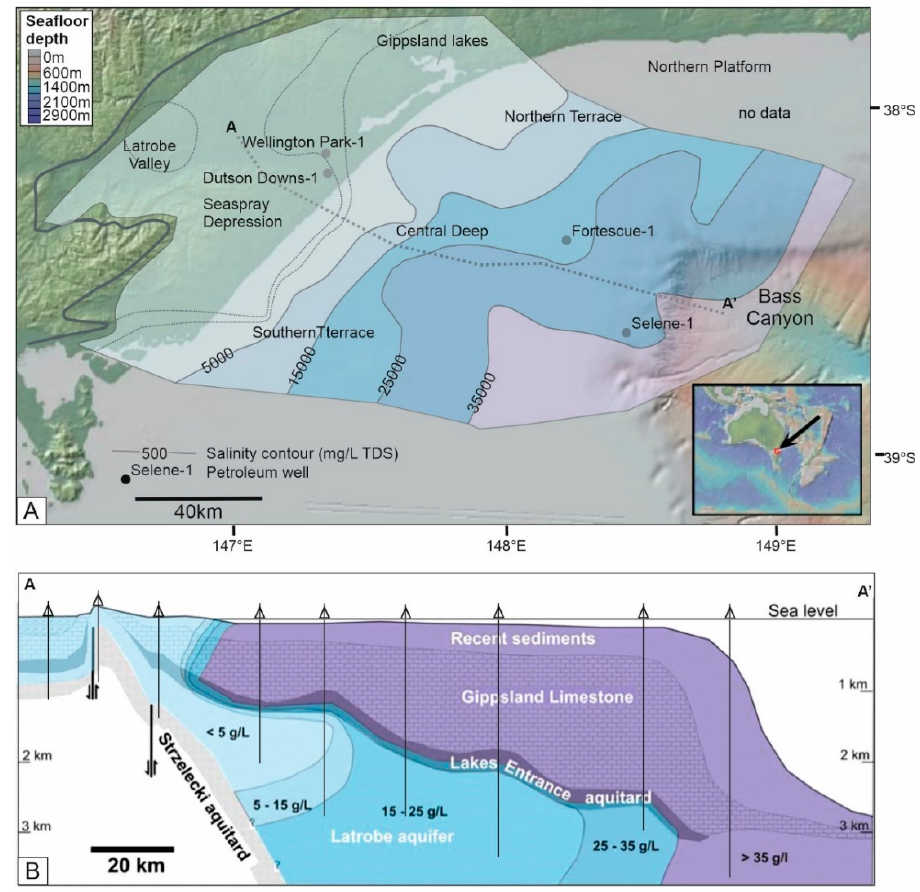
Figure 16. ( A ) Location map and salinity distribution in the Latrobe aquifer (mg/L) in the post-1980 period. Salinity is representative of the upper part of the Latrobe aquifer. Note irregular contour intervals for salinity < 000 mg/L ( light blue shading ). Otherwise, the contour interval is 10,000 mg/L. Location of schematic section indicated as A-A ′ . Map from geomapapp.com. ( B ) Schematic west–east section of the Gippsland Basin showing aquifers and aquitards. And salinity distribution (modified from Reference [151]).